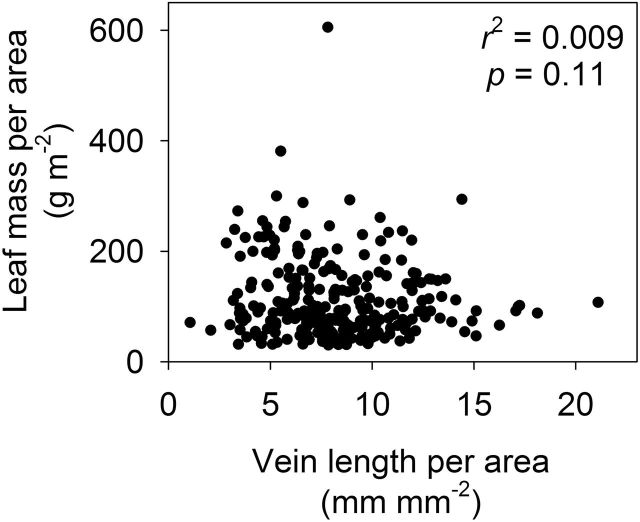
The independence of leaf mass per area (LMA) from vein length per leaf area (VLA) across phylogenetically diverse angiosperms. This is a replot of graph 3A of Sack et al. (2013), with additional data for 87 species of dicotyledons, for a total of 275 dicotyledonous species in 68 plant families. Additional data: six Hawaiian lobeliads, 29 Bolivian rainforest trees, and 52 species of Australian Proteaceae (data of Brodribb et al., 2013; Jordan et al., 2013; unpubl. data of L Sack, L Markesteijn, L Poorter, C Scoffoni, TJ Givnish, J Kunkle, R Montgomery, and M Rawls).